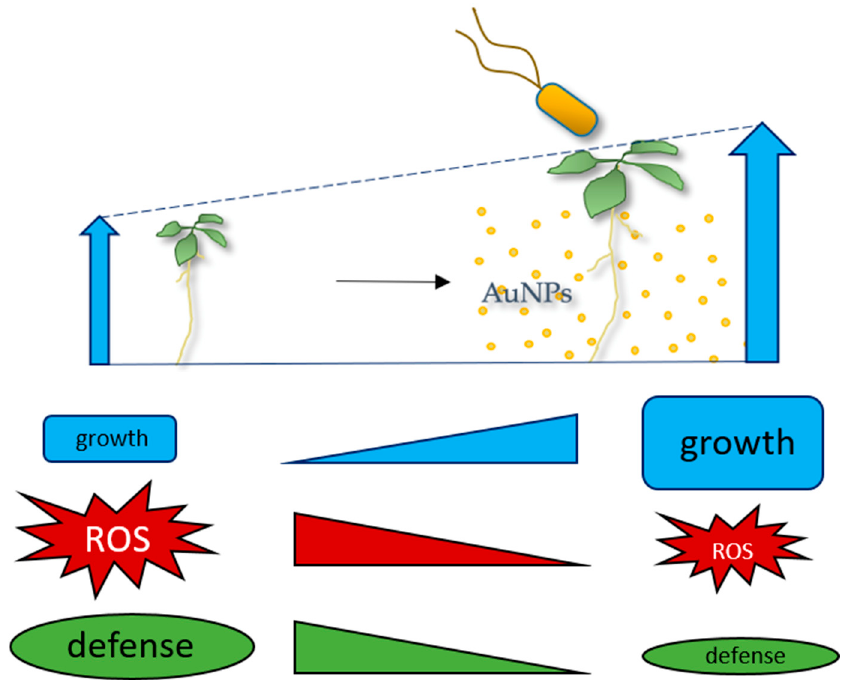
Figure 7. Model of AuNP effects on Arabidopsis seedlings. AuNPs stabilized with SCTA have growth-promoting effects on Arabidopsis seedlings and can reduce oxidative stress genes/proteins and ROS burst after triggering with the pathogen-associated molecular pattern (PAMP) flg22, indicating that the NPs can shift the trade-off between growth and defense responses to the growth side.